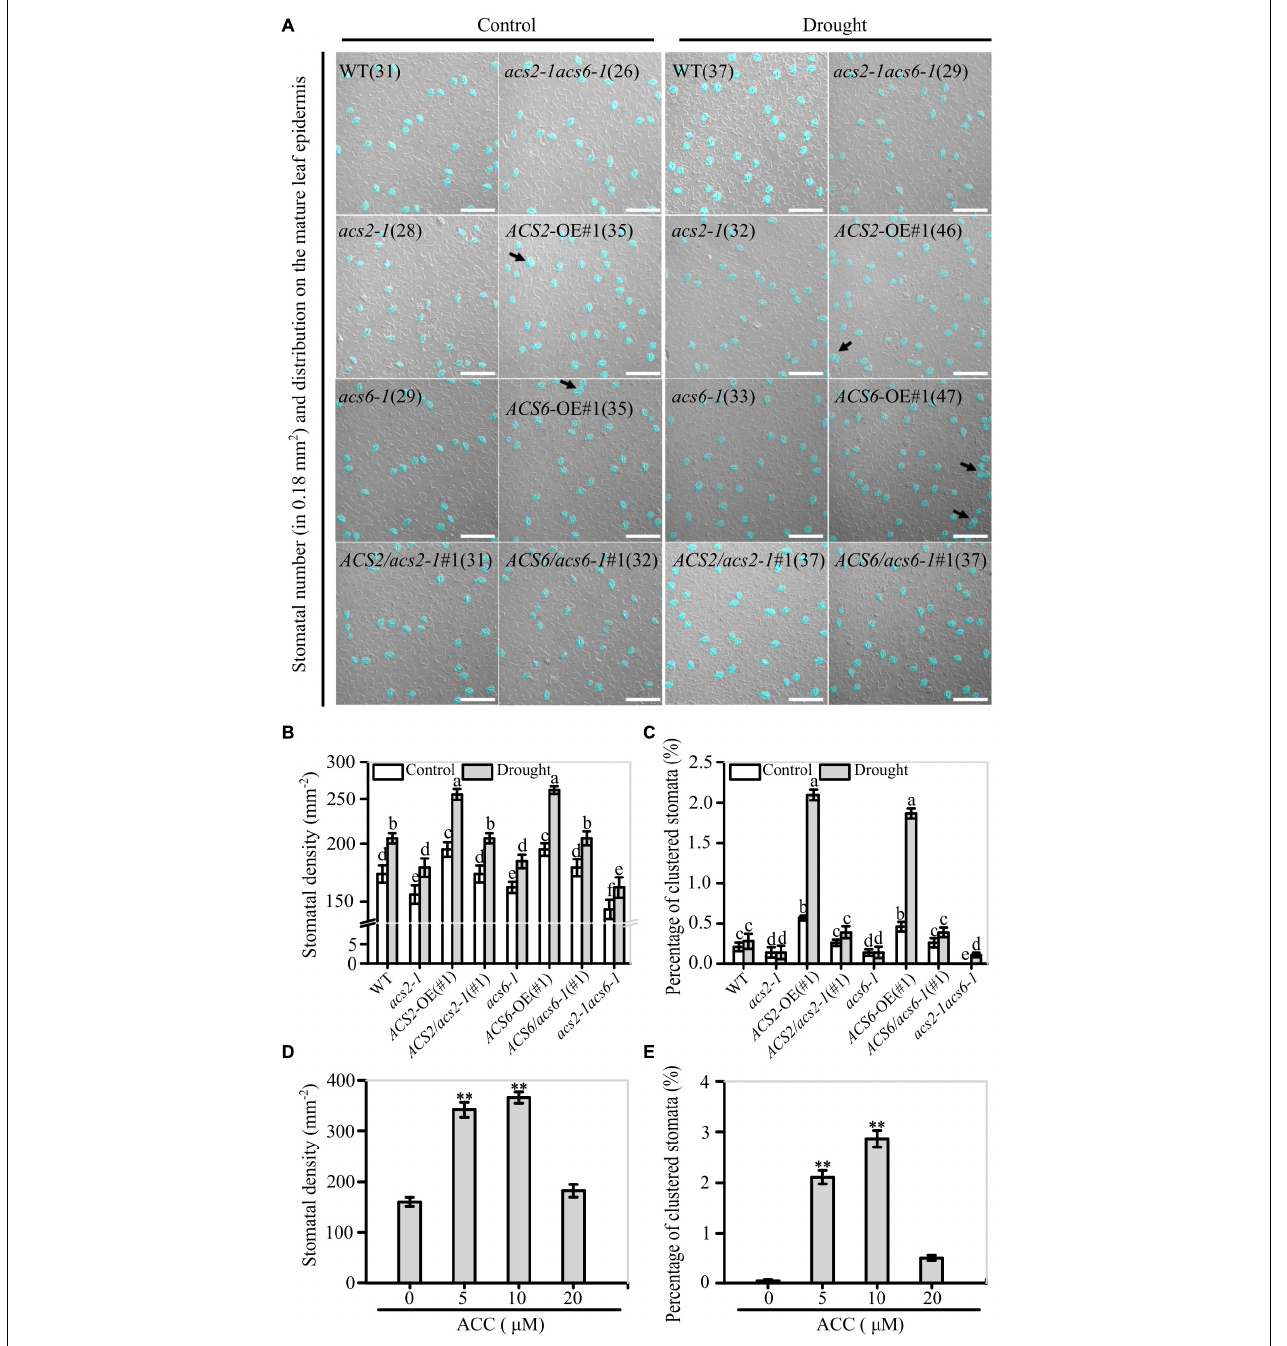
FIGURE 3 | Correlation between ACS2/6 activation and stomatal density and rate of stomatal clustering. (A) Images of stomata distributed on strips of leaf abaxial epidermis under differential interference contrast (DIC) microscopy. Stomata and stomatal clusters are colored in blue for easier identification, and stomatal clusters are indicated by black arrows. The number of stomata is given in parentheses in each image. Sixth rosette were collected under drought or normal watering conditions from 28-day-old seedlings of the WT control; mutants acs2-1 , acs6-1 , and acs2-1acs6-1 , overexpression lines ACS2 -OE(#1) and ACS6 -OE(#1), and complementation lines ACS2 / acs2-1 (#1) and ACS6 / acs6-1 (#1). Experiments were performed three times with similar results. The white scale bar represents 100 µ m. (B,C) Statistical analysis of stomatal density (B) and percentage of clustered stomata (C) under normal and drought condition. Number of stomata and stomatal clusters on sixth leaves of 25 seedlings were counted. Values are means ± SD ( n = 25 repeats). Letters indicate significant differences ( P < 0.05, two-way ANOVA). (D,E) After treated immature leaves by ACC (0–20 µ M) for 6 days, stomatal density (D) and percentage of clustered stomata (E) were analyzed, respectively. A total of 25 leaves from 25 seedlings were used to analyze the numbers of stomata and percentage of clustered stomata. Values are means ± SD. (Student’s t -test, ∗∗ P < 0.01).